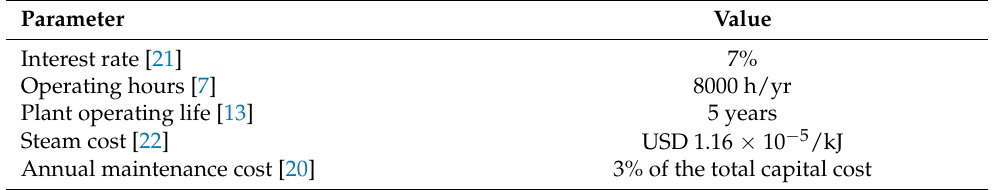
Table 9. Assumptions for the cost analysis.